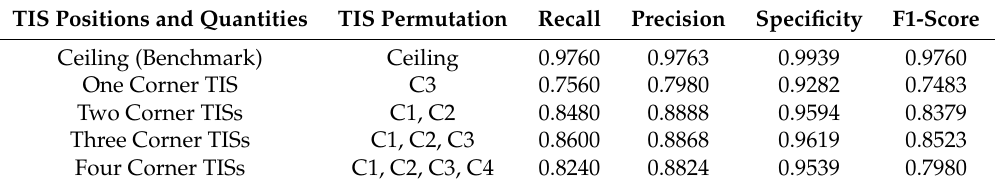
Table 16. The comparison of attained recognition scores between the best scoring approaches for each TIS permutation and the benchmark when using the random forest model.